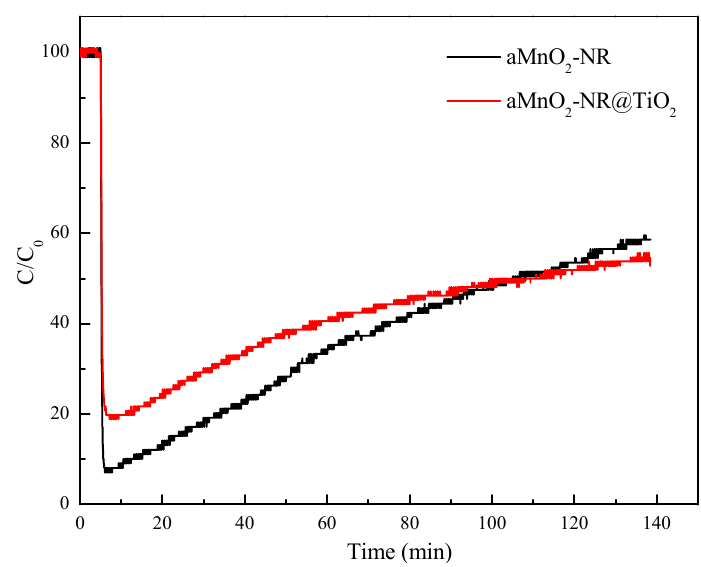
Figure 4. Hg 0 breakthrough curves of α MnO 2 -NR and α MnO 2 -NR@TiO 2 under pure N 2 atmosphere. Reaction condition: 150 ◦ C, GHSV = 180,000 h − 1 .